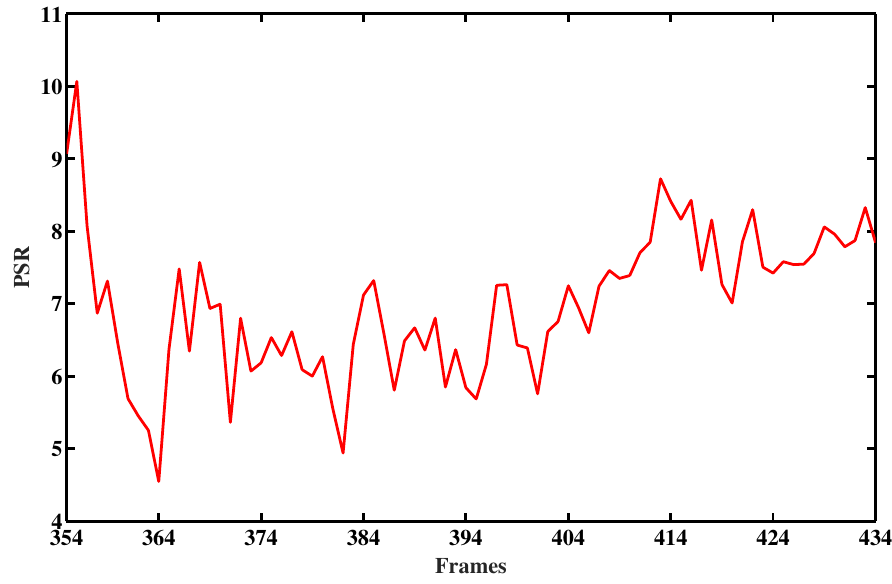
Figure 3. The peak to sidelobe ratio (PSR) of image response